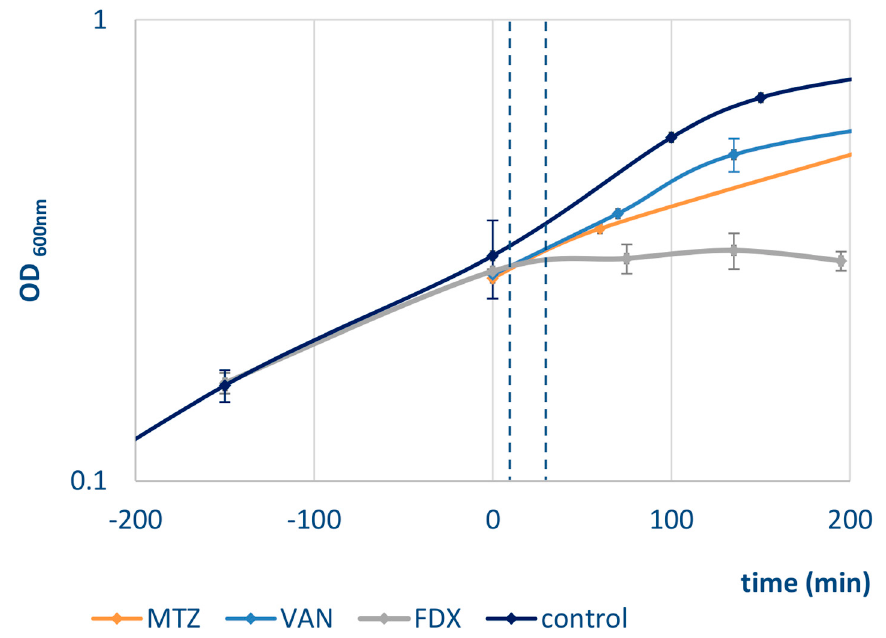
Figure 1. Growth of C. difficile 630 ∆ erm was performed at 37 ◦ C in brain heart infusion (BHI) in an anaerobic chamber. At time = 0 min (exponential growth phase, OD 600nm of 0.4) cultures were stressed with either metronidazole (MTZ, orange), vanomycin (VAN, light blue) or fidaxomicin (FDX, grey) or left untreated (control, dark blue). The antibiotic concentration used resulted in reduced growth rates compared to an untreated control culture. Stress samples were taken 10 min and 30 min after addition of the antibiotic (dashed lines).